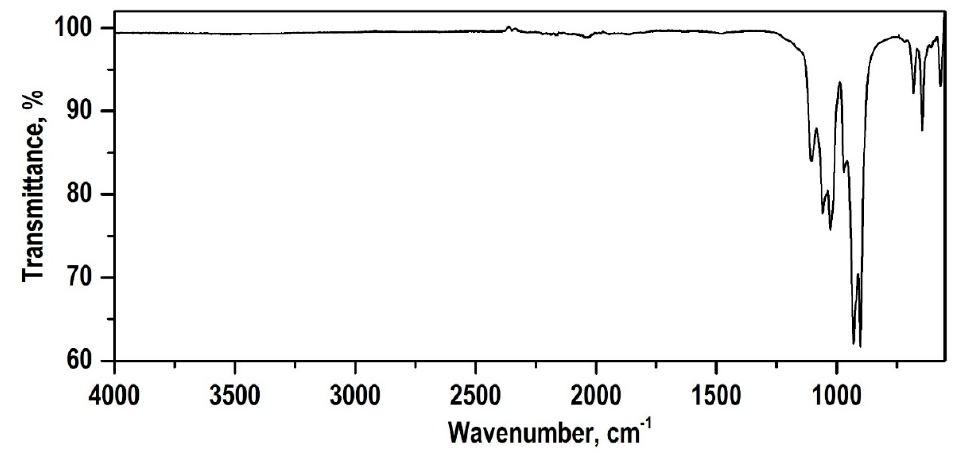
Figure 4. Infrared (IR) spectrum of the autoclave synthesis product sample in the CaSO 4 ·2H 2 O– SiO 2 · n H 2 O–KOH–H 2 O system after calcination at 900 °C.